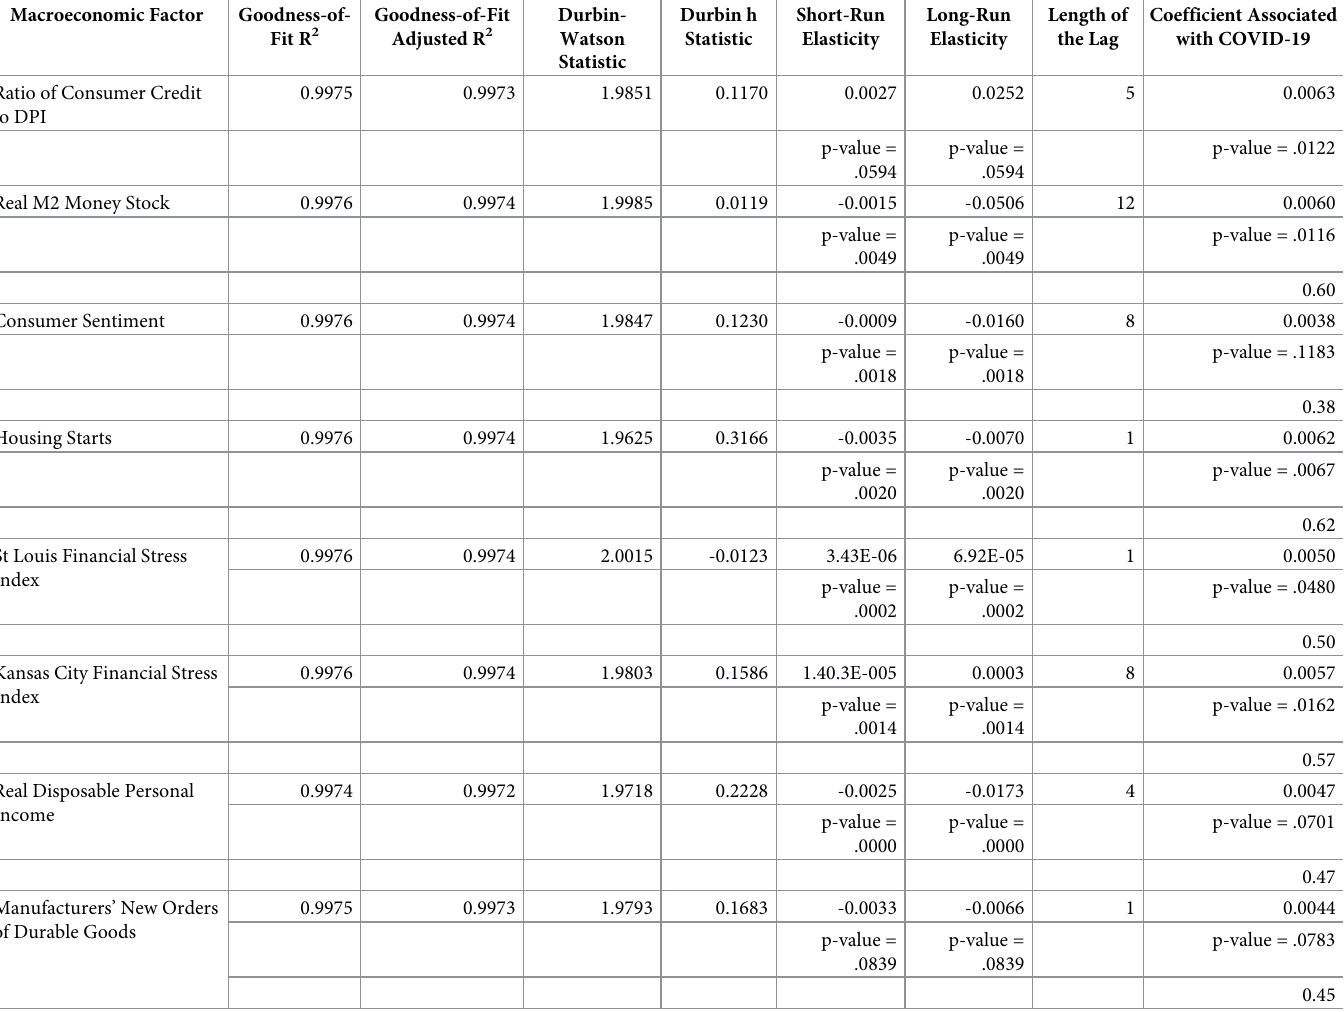
Table 5. Key metrics of the econometric distributed lag models concerning WIC participation by macroeconomic